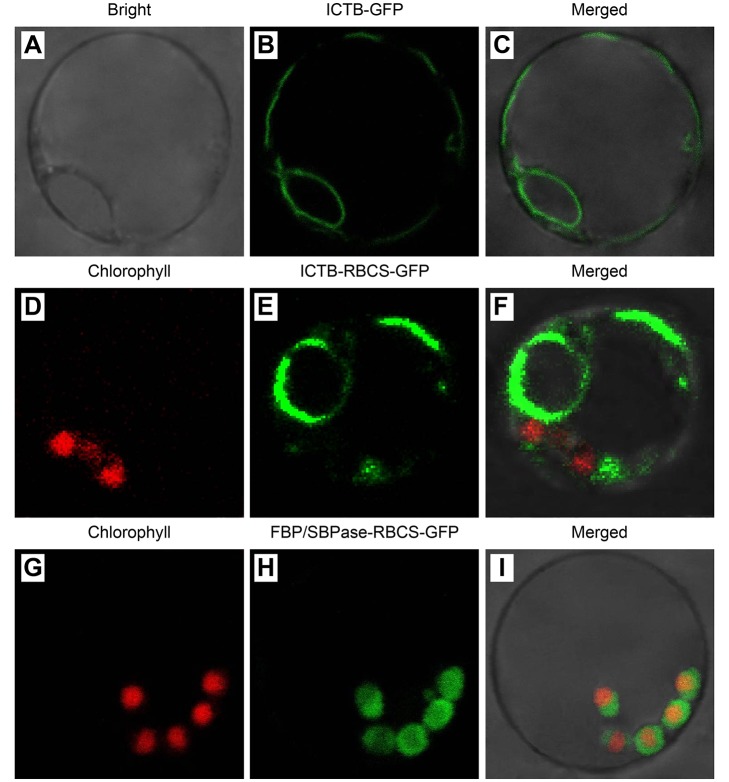
Subcellular localization of ICTB and FBP/SBPase protein.
A, Bright field view of protoplasts. B, GFP
signals from the ICTB-GFP fusion protein. C, Merged images.
D, Red chlorophyll autofluorescence used as a
chloroplast marker. E, GFP signals from the ICTB-RBCS-GFP
fusion protein. F, Merged images. G, Red
chlorophyll autofluorescence. H, GFP signals from the
FBP/SBPase-RBCS-GFP fusion protein. I, Merged images, with
yellow fluorescence in the merged images due to red chloroplast
autofluorescence.